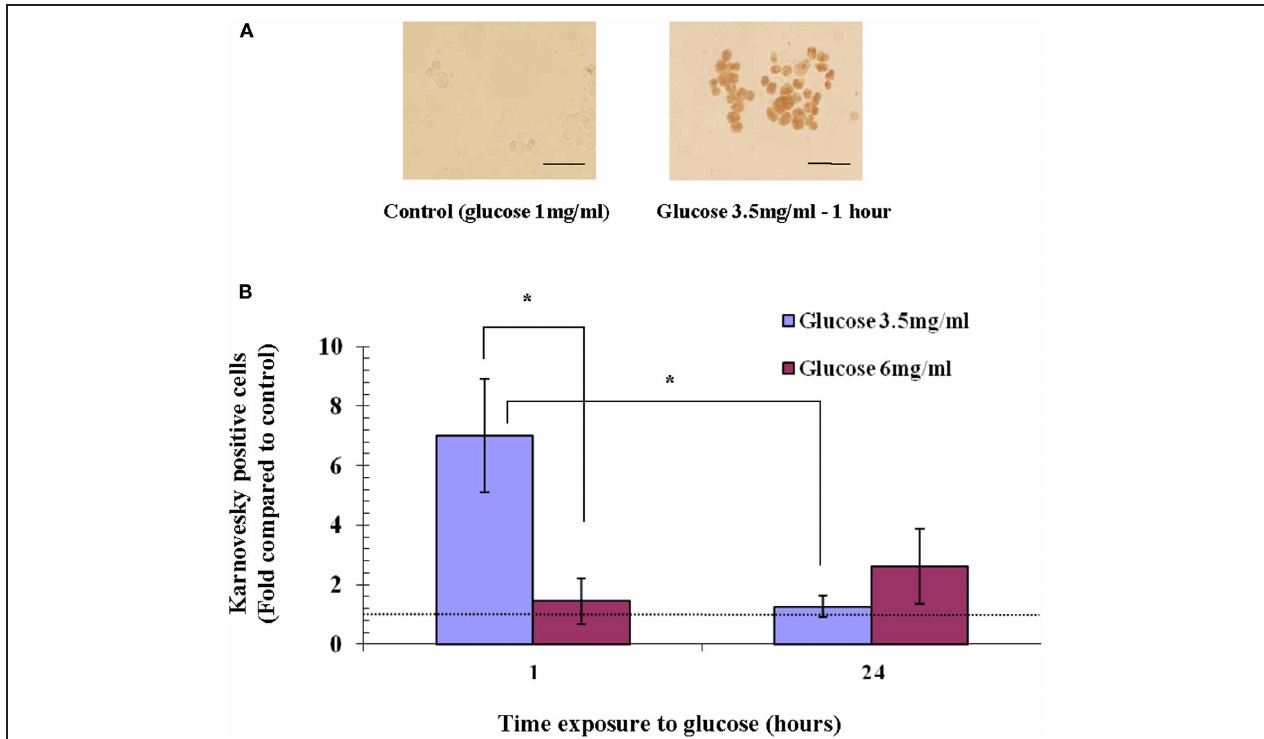
FIGURE 4 | AChE activity in Y79 cells treated with glucose. Y79 cells were pre-treated for 16–24h in starvation medium (1% FBS and 1mg/ml of glucose), and then with 3.5mg/ml or 6mg/ml glucose for 1h or 24h, after which Karnovsky and Roots assay was performed. Positive Karnovsky and Roots staining is seen in (A) on the right side compared to the negative